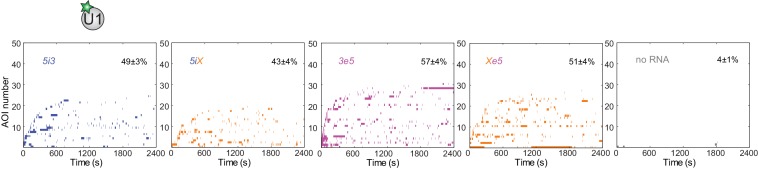
Rastergrams showing U1 binding to 50 randomly selected 5i3, 5iX, 3e5, and Xe5 pre-mRNA molecules and 'no RNA' control locations over the course of 2,400 s, sorted by the time of the first binding event.Data are from the experiment in Figure 3B. The percentage (±s.e.) of N observed RNA molecules (see Figure 3B) that exhibited subcomplex binding during the experiment is indicated.